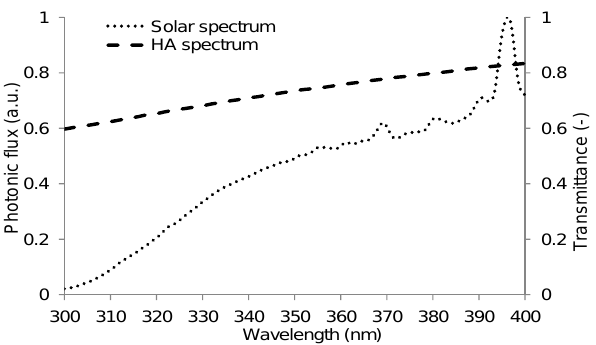
Figure 3. Transmission spectrum of HA was measured by Hach Lange DR 5000 spectrophotometer and the normalized emission spectrum of artificial solar light was measured by Black C-50 spec- trometer, a product of StellarNet